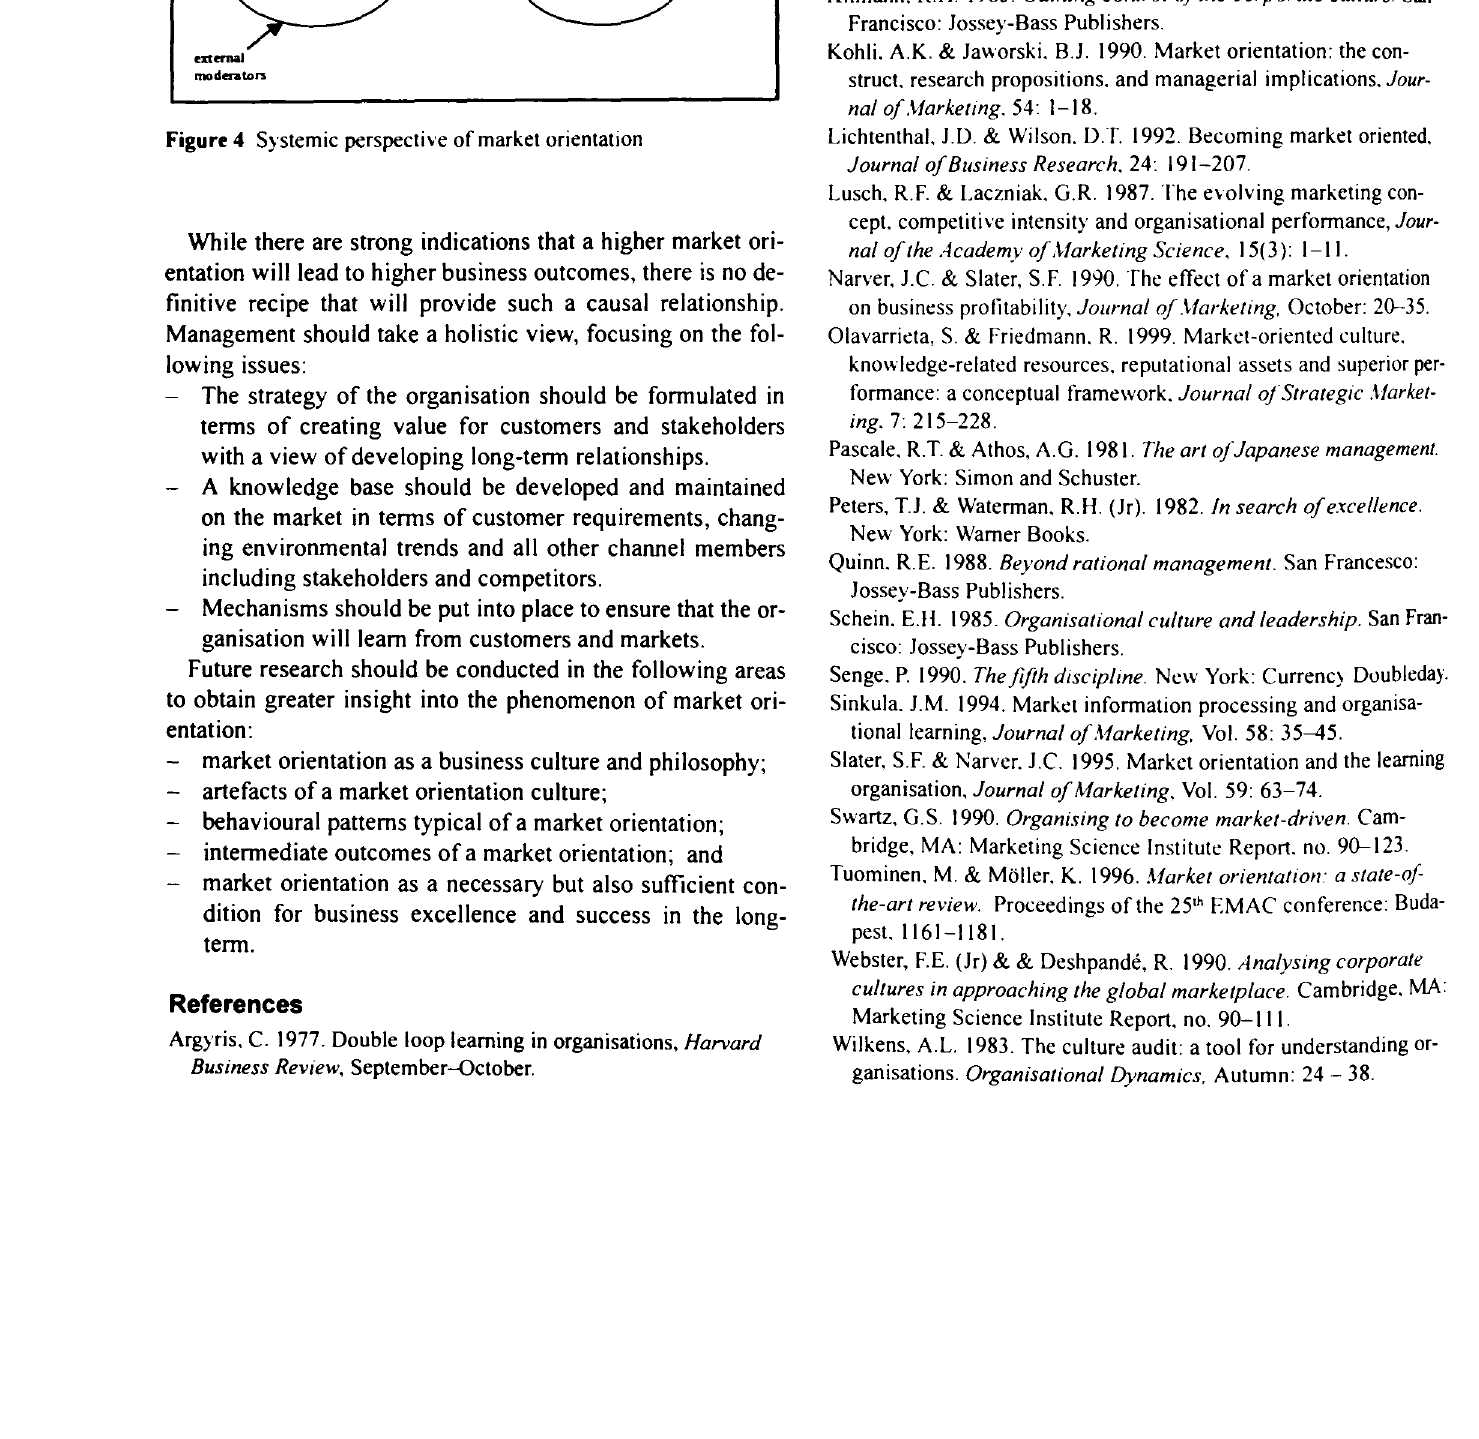
Figure 4 Systemic perspective of market orientation